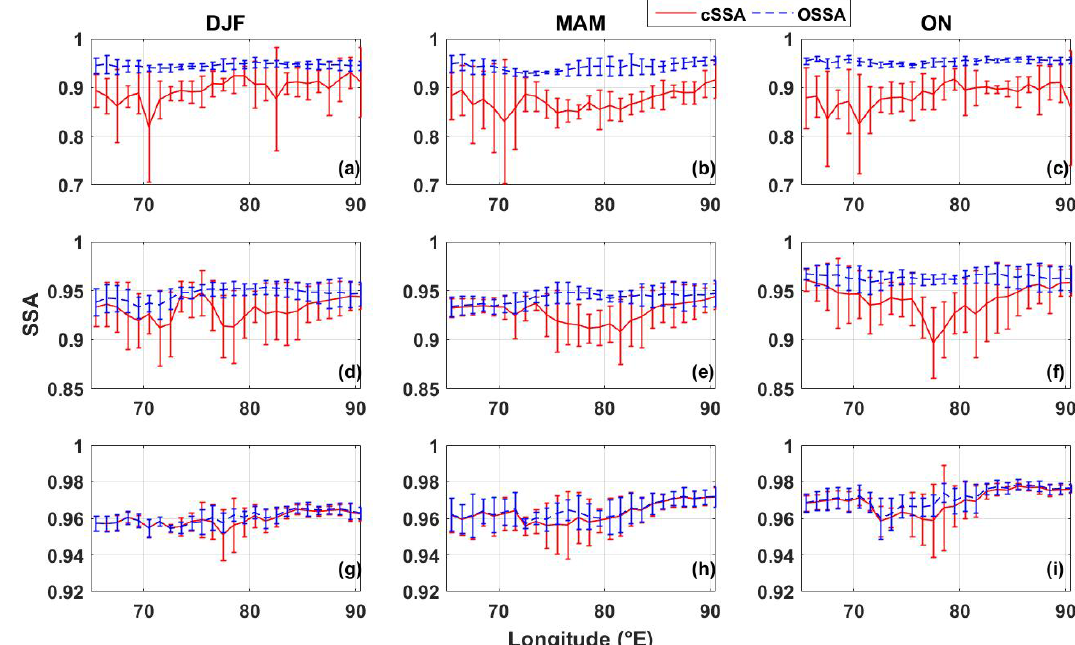
Figure 5. Zonal variation in cSSA (combined SSA) and OMI SSA in SR1, SR2, and SR3 during DJF, MAM, and ON seasons. The rows from top to bottom correspond to sub-regions SR1, SR2, and SR3